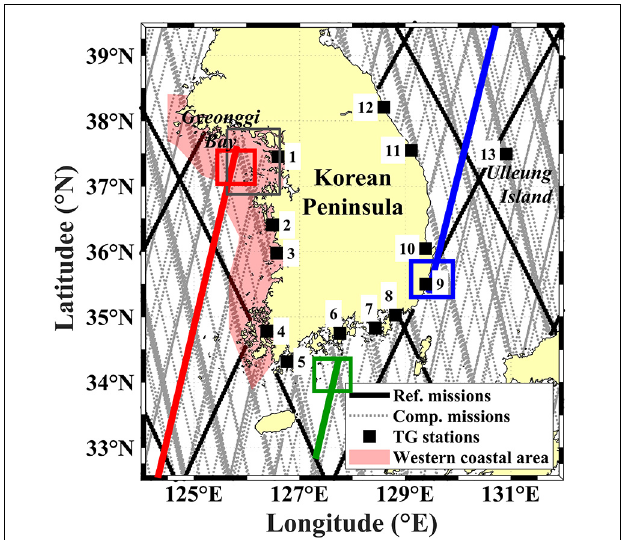
FIGURE 1 | Tracks of reference (black) and selected complementary (gray) satellite altimetry missions, and locations of tide gauge (TG) stations around Korean Peninsula (KP) labeled with numbers (black squares). Sea level anomalies (SLAs) along three descending tracks crossing the west (thick red line), south (thick green line), and east (thick blue line) coasts of KP are shown for comparative purposes. Areas near the coast ( < 50 km) in these selected tracks are highlighted by colored boxes. The western coastal area and Gyeonggi Bay area near the TG station IC (number 13), where the tidal ranges were relatively high, are shown by red shading and a 1 ◦ × 1 ◦ gray box,